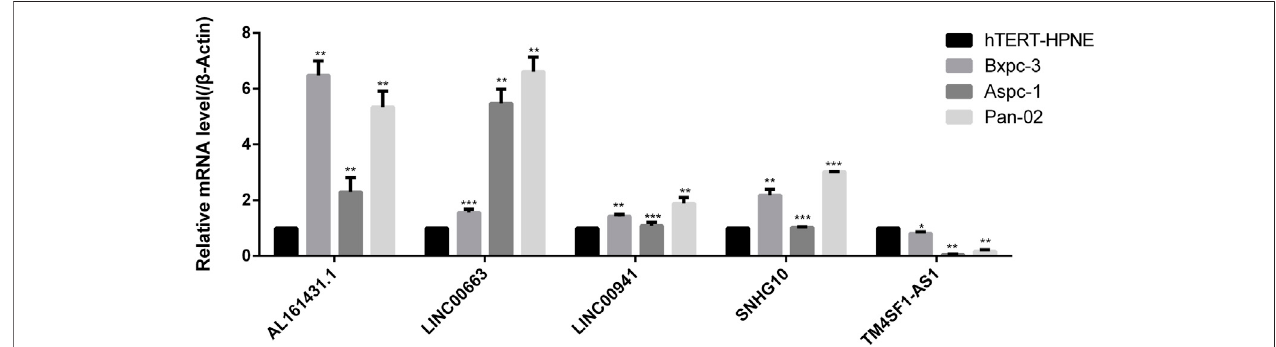
FIGURE 12 | RT-PCR was used to detect the expression levels of AL161431.1, LINC00663, LINC00941, SNHG10, and TM4SF1-AS1 in normal pancreatic and pancreatic cancer samples (* p < 0.05, ** p < 0.01, *** p <